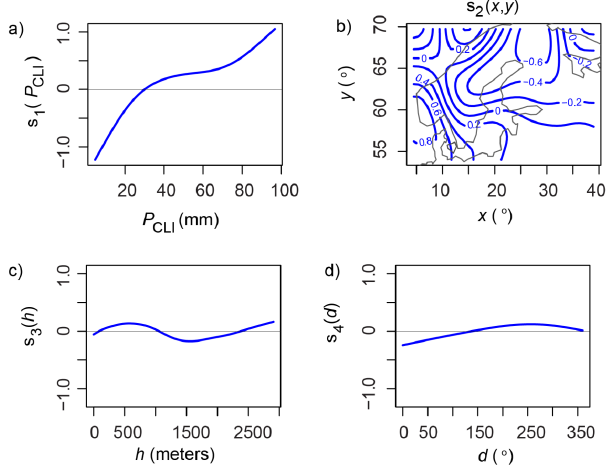
Figure 2. Components of the GAM model in Eq. (3) fitted to down- scale the CLIMBER-2 January log-precipitation in the recent past, MIS 3 stadial and LGM climates. The blue curves show the esti- mated effects of (a) CLIMBER-2 total precipitation, (b) longitude and latitude, (c) elevation, and (d) direction of the steepest slope.